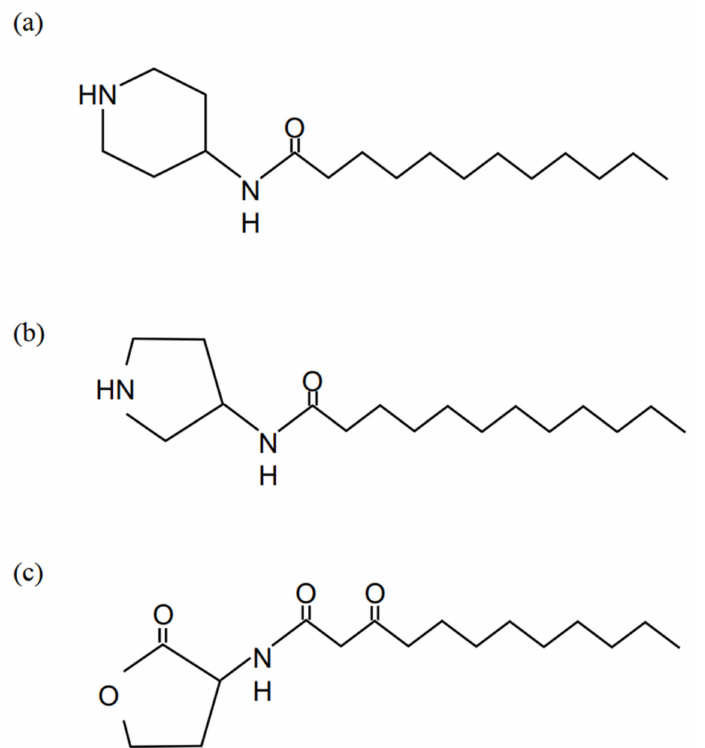
Figure 1. The structure of AIA-1 ( N -(piperidine-4-yl)-dodecanamide) ( a ), and AIA-2 ( N -(pyrrolidine-3- yl)-dodecanamide) ( b ), the analog of OdDHL ( N -3-oxododecanoyl-homoserine lactone). The structure of OdDHL ( c